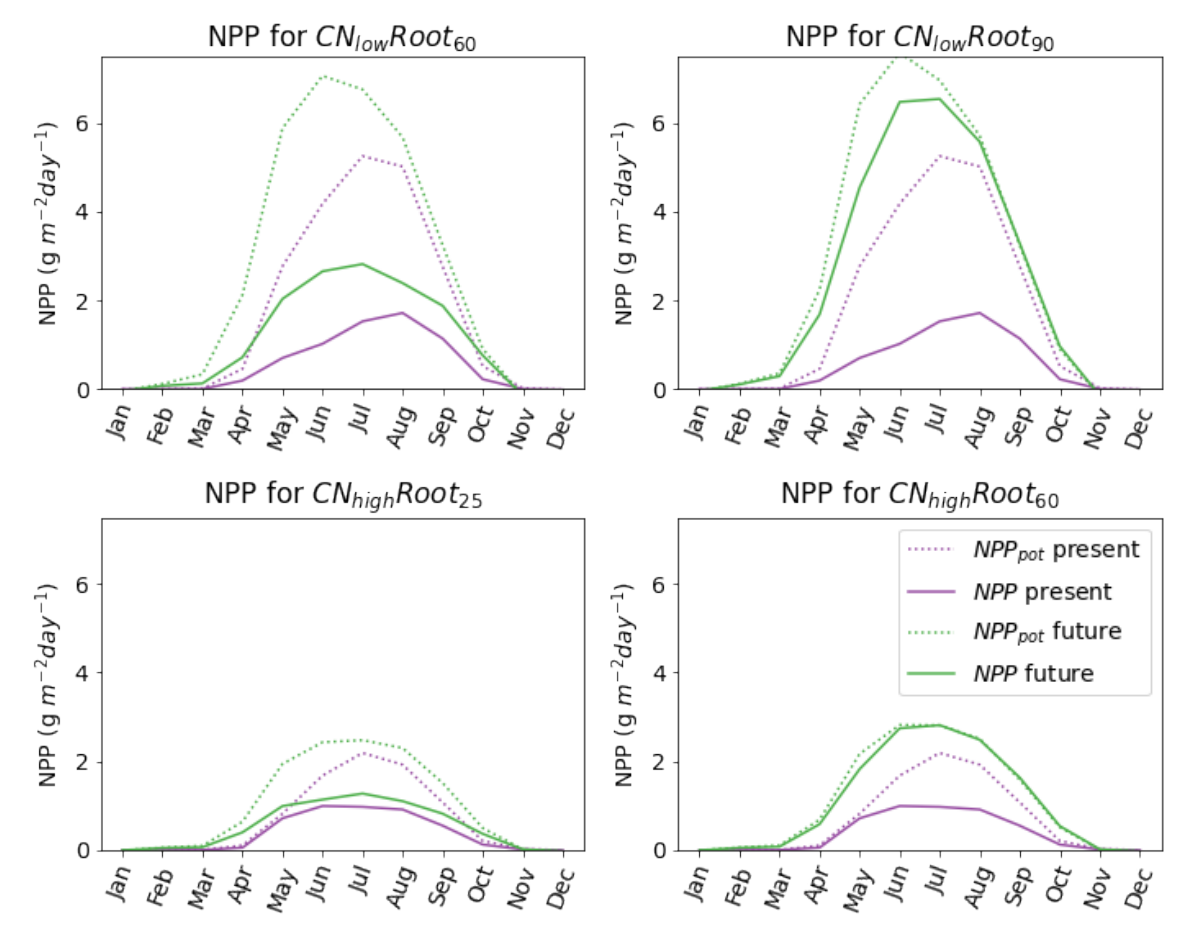
Figure 8. Potential NPP (NPP pot ) and nitrogen-limited NPP for the period 2000–2010 (present) and the period 2090–2100 (future under RCP8.5 scenario) displayed as a 10-year monthly average. The left-hand column shows the future projections of NPP for the original vegetation types and the right-hand column shows that for a proposed future vegetation type, where the root depths are able to increase because the permafrost has thawed. The present-day NPP is for CN low Root 60 and CN high Root 25 , respectively, for both left and right